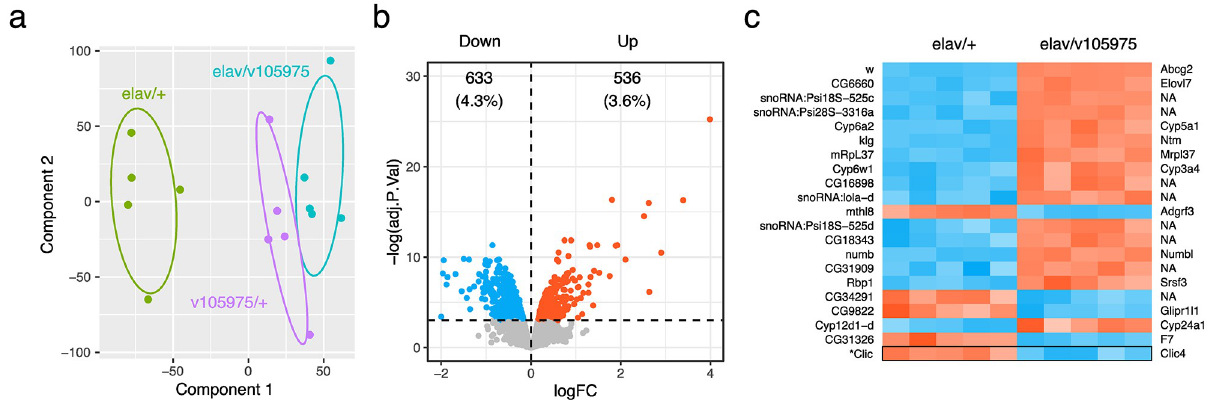
Fig 2. Clic knockdown-responsive gene expression. (a) PCA plot depicting expression profiles for control ( elav /+), RNAi only (v105975/+) and Clic knockdown flies ( elav /v105975) with normal confidence ellipses. (b) Volcano plot for complete differential gene expression results between Clic knockdown ( elav /v105975) and control ( elav /+) genotypes, highlighting significantly downregulated (blue) and upregulated (red) genes (FDR � 0.05). (c) Heatmap of top 20 differentially regulated genes, ranked by FDR. Fly genes are listed on left and corresponding human orthologs on right (NA indicates no clear ortholog at time of publication). Clic expression added to bottom row of heatmap for clarity.